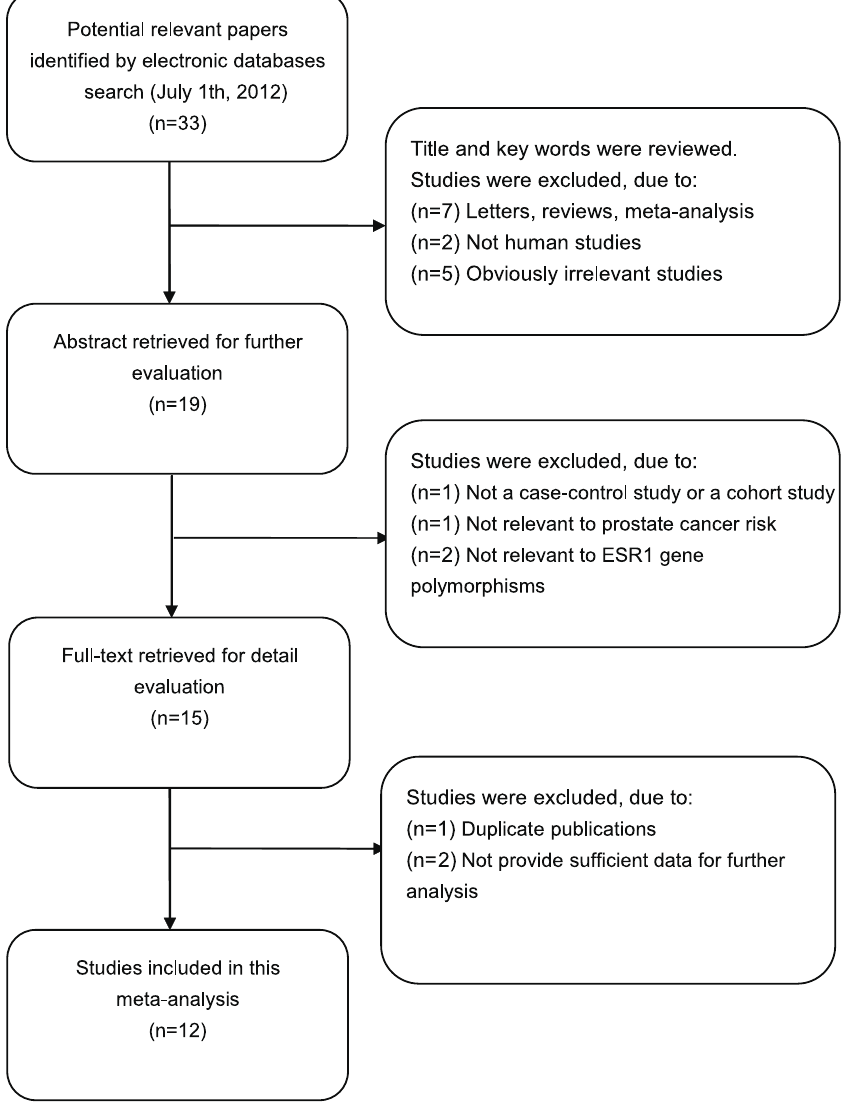
Figure 1. Flow chart of literature search and study selection.